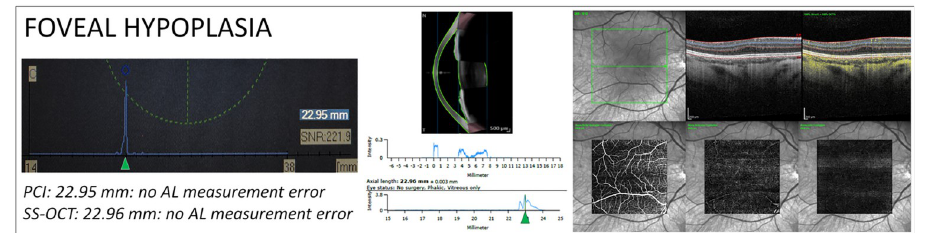
Fig 4. AL measurements in a patient with foveal hypoplasia. Biometric outputs, OCT and OCT-angiography (OCT-A) from a young patient with foveal hypoplasia. Left part: PCI biometric output. The measured mean AL is 22.95 mm. Only one peak is visible (green arrowhead). Middle part: SS-OCT biometric output (bottom). The measured mean AL is 22.96 mm. A moderate double peak is visible, with the first likely representing the vitreoretinal interface and the second the RPE (green arrowhead). Right part: Upper row: Infrared image (left), structural OCT B- scan passing through the fovea (middle) and structural B-scan with flow overlay (yellow dots). Lower row: enface OCT-A scans from the superficial vascular complex (left), deep vascular complex (middle) and avascular complex (right). AL measurements from both devices were considered correct.